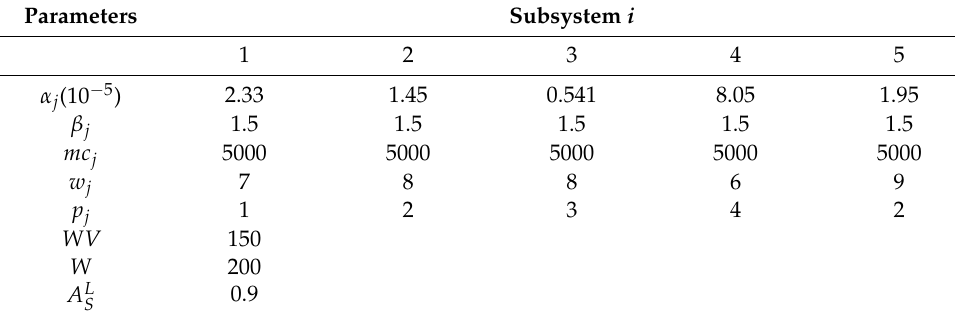
Table 2. Parameters adopted in the upcoming simulation